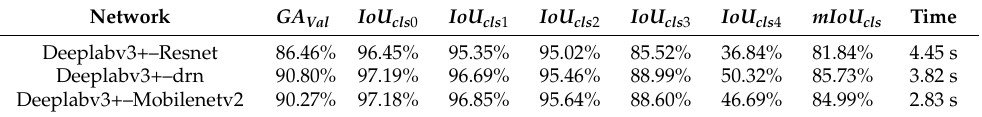
Table 3. The results of the three networks based on the proposed potential energy loss function.